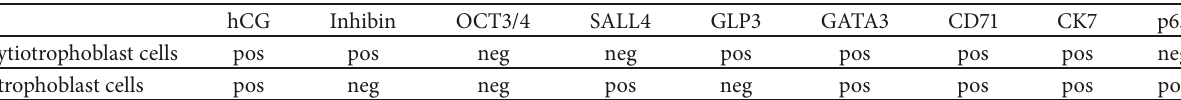
Table 1: Immunohistochemical expression profile.